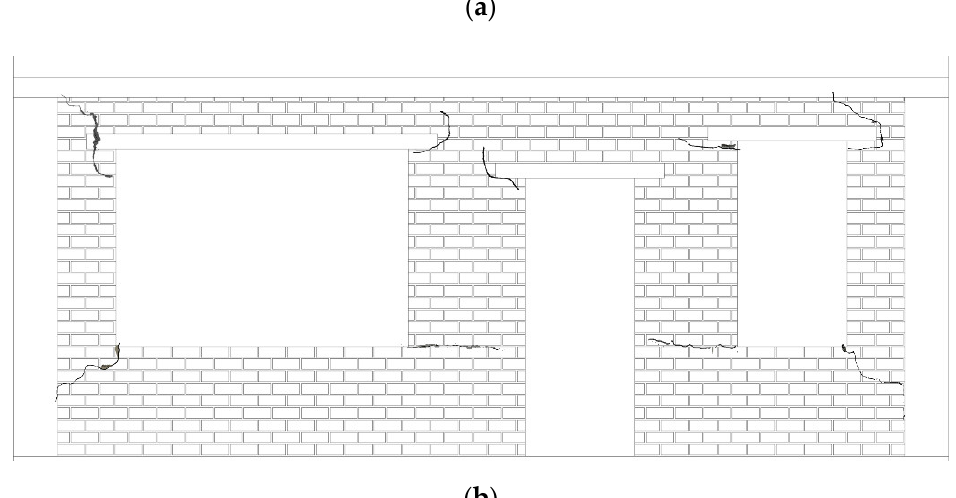
Figure 13. Cracks in the wall of the structure model of the non-isolation test: ( a ) north wall; ( b ) south wall.